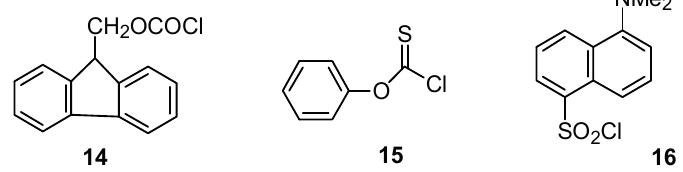
Figure 8. Structures of additional substrates: 9-fluorenylmethyl chloroformate ( 14 ); phenyl